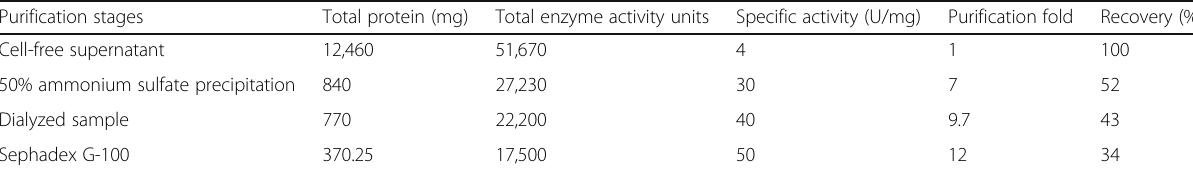
Table 1 Summary of the purification of protease from S. hydrogenans var. MGS13 Purification stages